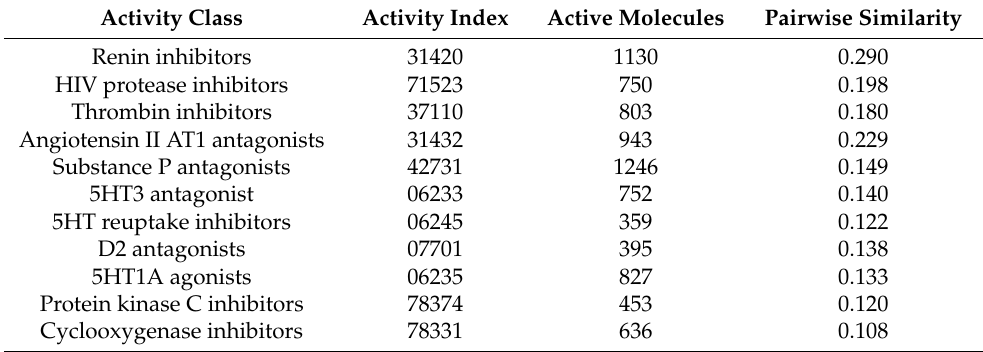
Table 1. The MDDR-DS1 (structurally homogeneous and heterogeneous) activity classes.